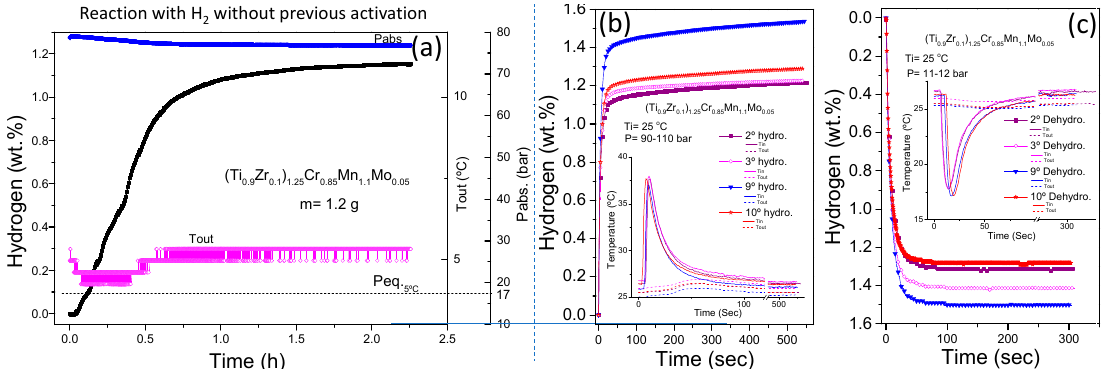
Figure 3. ( a ) First hydrogenation of initial sample after synthesis without previous activation under around 80 bar and 5 °C, and ( b ) hydrogenation and ( c ) dehydrogenation cycling under 90–110 bar and 11–12 bar, respectively, for (Ti 0.9 Zr 0.1 ) 1.25 Cr 0.85 Mn 1.1 Mo 0.05 (button of alloy broken into pieces by hand with a tool, m = 1.2 g, Sieverts apparatus [62]).